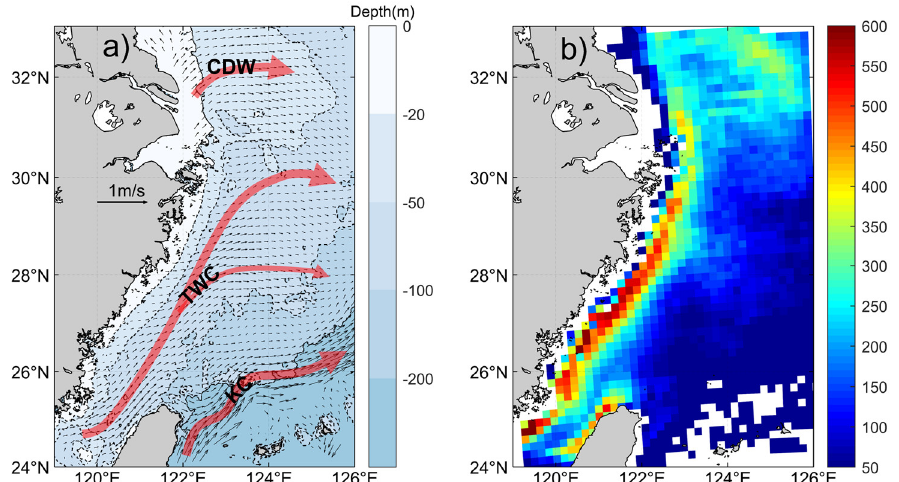
Figure 5. ( a ) GOCI−derived climatic current field; ( b ) spatial distribution of the number of velocity vectors in the flow field. KC : Kuroshio Current; TWC : Taiwan Warm Current; CDW : Changjiang Diluted Water. The red arrows in 5( a ) show the trajectory of the currents.